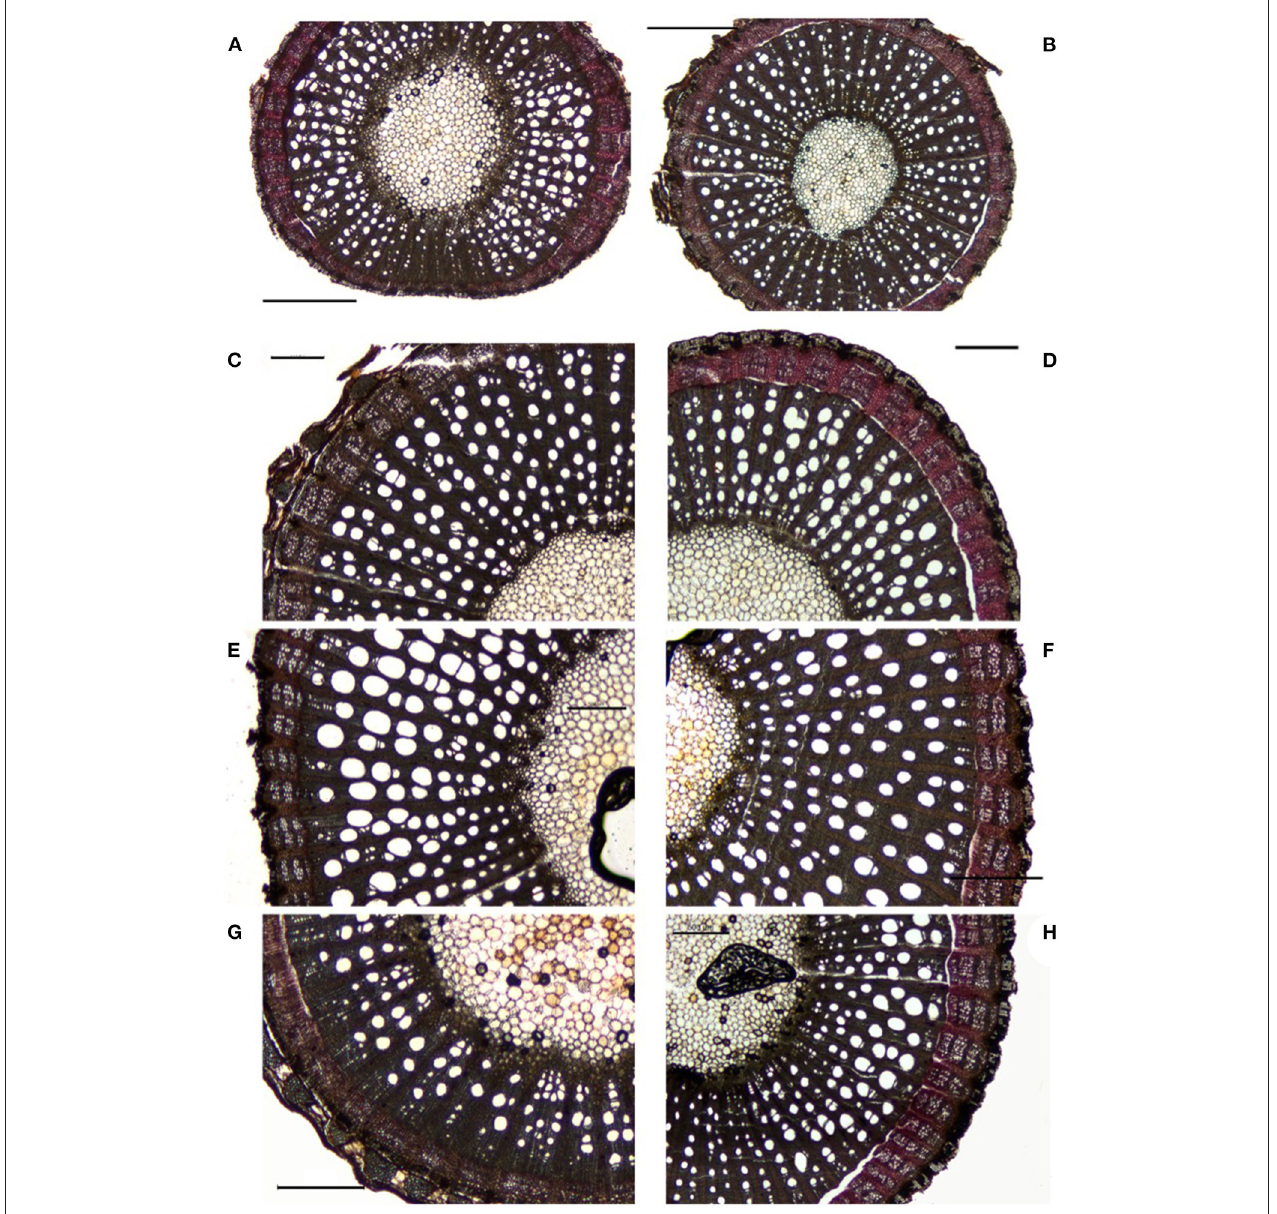
FIGURE 2 | Image analysis for the different rootstocks 60 µ m sections. Blanchard 1 (A) , Castel 6736 (B) , Grezot G1 (C) , Rupestris Fort Worth 1 (D) , RG9 (E) , Richter 110 (F) , Grimaldi 791 (G) , and SO4 (H) . Horizontal bars = 500 µ